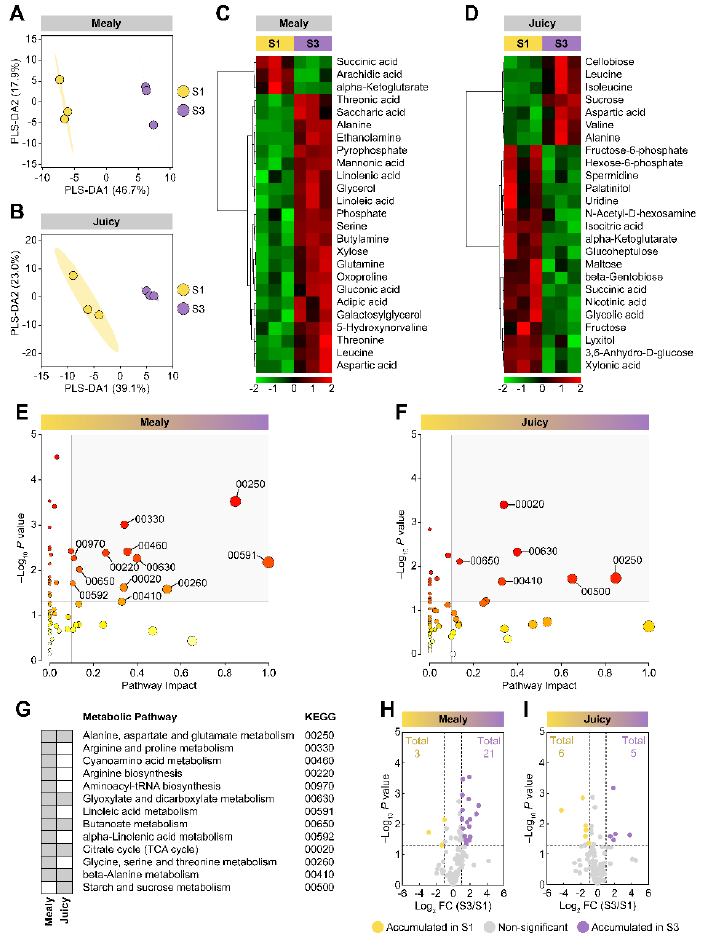
Figure 2. Multivariate analyses of metabolites of mealy and juicy unripe nectarines after cold storage. Partial Least Squares Regression Discriminant Analysis (PLS − DA) for S1 and S3 stages and score plot of mealy ( A ) and juicy ( B ) varieties. The identified metabolites were employed as predictor variables and the varieties as response variables. Heatmap representation based on top 25 metabolites identified by PLS − DA VIP of S1 and S3 stages from the mealy ( C ) and the juicy ( D ) varieties. The columns represent biological replicates for each treatment. The similarity measure used to group the different characteristics was based on Euclidean distance and Ward’s linkage from three biological replicates ( n = 3). Pathway analysis of S1 and S3 stages from the mealy ( E ) and the juicy ( F ) varieties. Perturbed metabolic pathways and their KEGG entries are highlighted in grey ( G ). Three biological replicates ( n = 3) and the Arabidopsis thaliana pathway library were used for this analysis. Volcano plots showing differentially accumulated metabolites (DAMs) from mealy ( H ) and juicy ( I ) varieties.